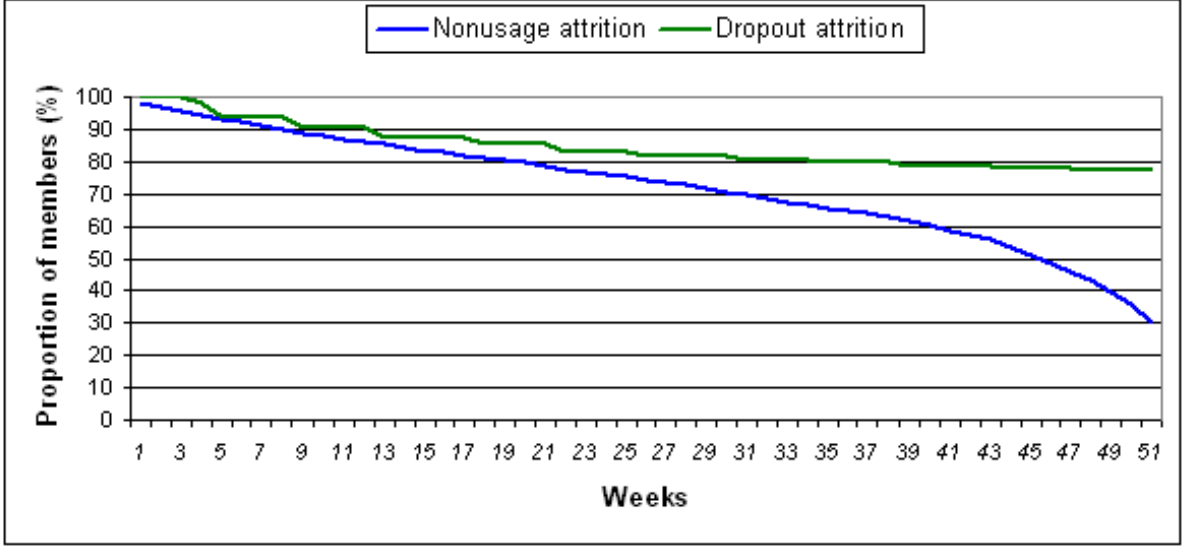
Figure 5. Dropout and nonusage attrition from enrollment to 52 weeks among 52 week